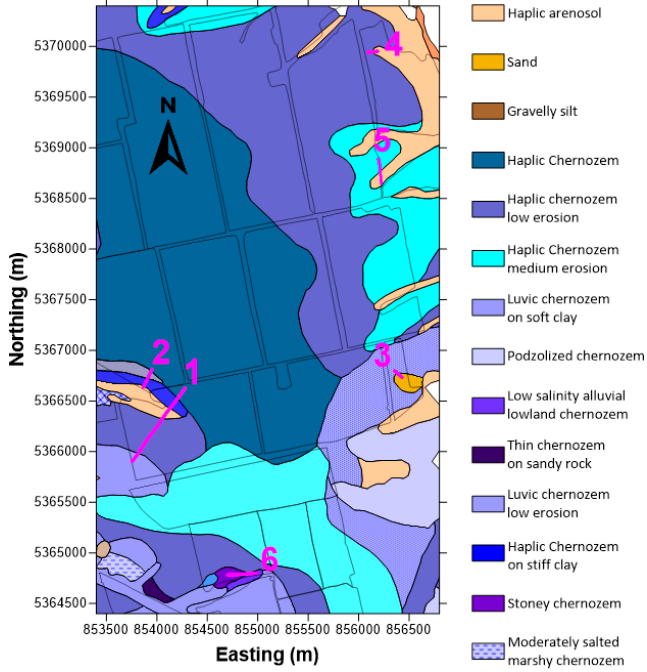
Figure 2. Transect locations and soil map of the study area.